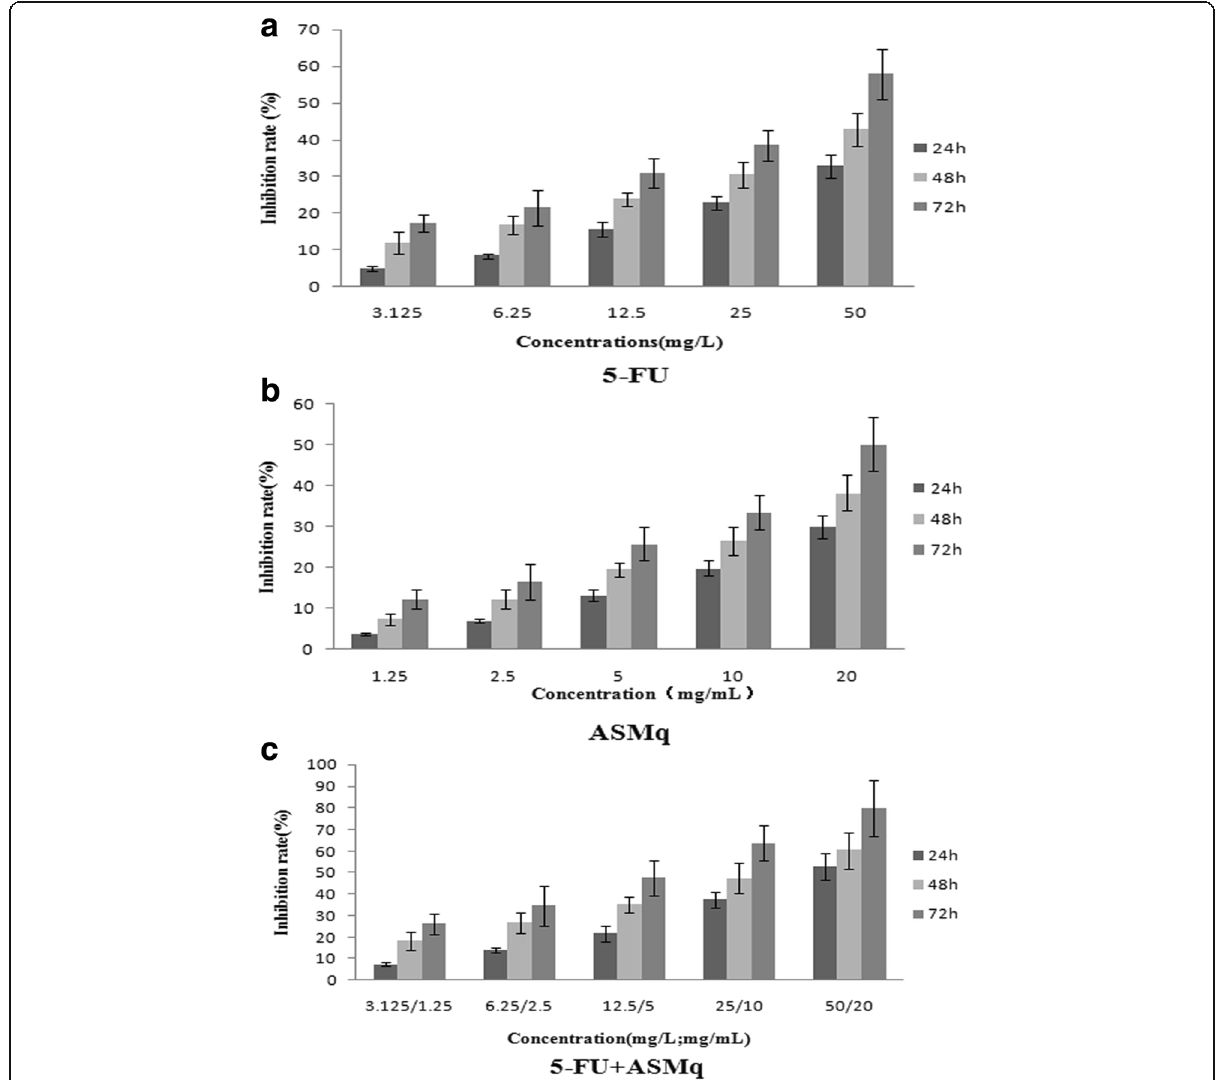
Fig. 1 Inhibitory effect of ASMq or/and 5-fluorouracil on the growth of U27 cells. a Growth inhibition rate of U27 cells following 24, 48 or 72 h treatment with increasing concentrations of 5-fluorouracil. b Growth inhibition rate of U27 cells following 24, 48 or 72 h treatment with increasing